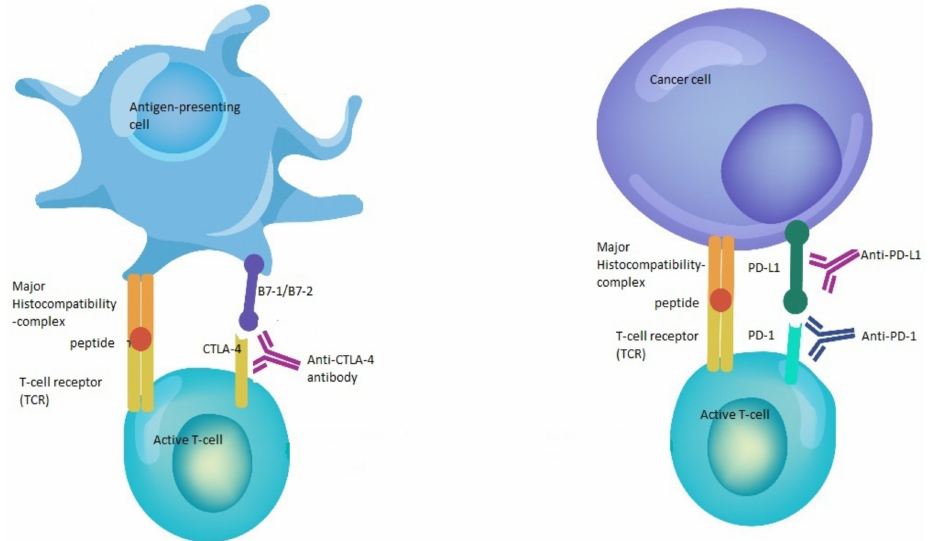
Figure 1. Mechanisms of action of immune checkpoint inhibitors. The binding of B7-1/B7-2 to CTLA-4 keeps the T cells in the inactive state so that they are not able to kill tumor cells in the body. Blocking the binding of B7-1/B7-2 to CTLA-4 with anti-CTLA-4 antibody allows the T cells to be active and to kill tumor cells. In the same way, the binding of PD-L1 to PD-1 prevents the T cells from killing cancer cells. The interruption of this binding using anti-PD-1/PD-L1 enhances the ability of T cells to kill tumor